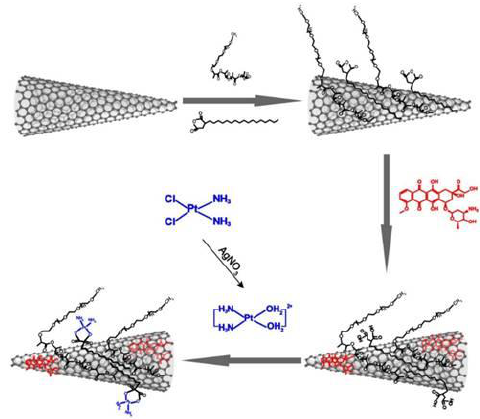
Figure 4. Schematic representation of the preparation of Cisplatin and Doxorubicin dual loaded Single-Walled Carbon Nanohorns. Reproduced from [100]. Ivyspring (2018).